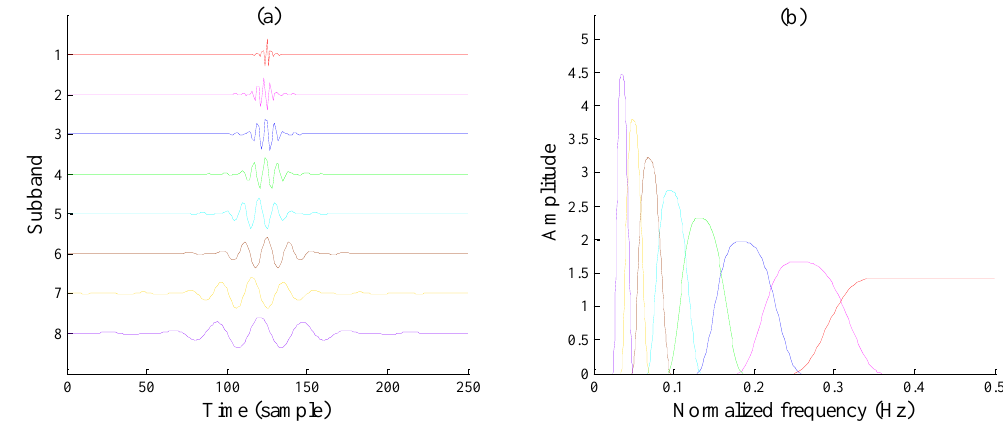
Figure 4. A typical RADWT wavelet base with p = 18, q = 25, s = 2. ( a ) Time-domain waveforms; ( b ) Frequency responses.